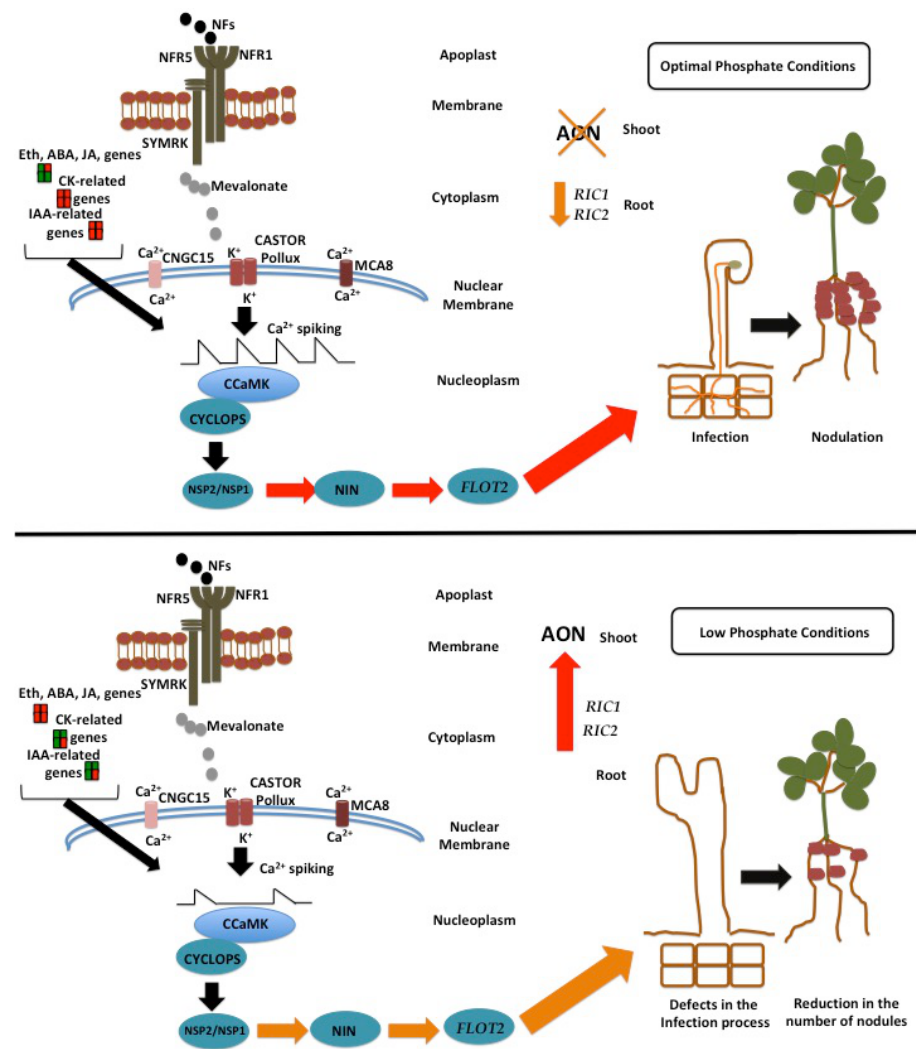
Figure 9. Proposed model of the effects of Pi deficiency in the early steps of the symbiosis between common bean and rhizobia. Higher induction, lower induction and down-regulation of the expression of different rhizobia-induced genes is indicated in red, orange, and green, respectively. Upon NF perception, a variety of molecular responses occurs. For example, the accumulation of mevalonate at the cytoplasm is required for the activation of the Ca 2+ spiking [97]. These fluxes of calcium are further transduced by CCaMK, which in turn activates the transcription factor CYCLOPS.